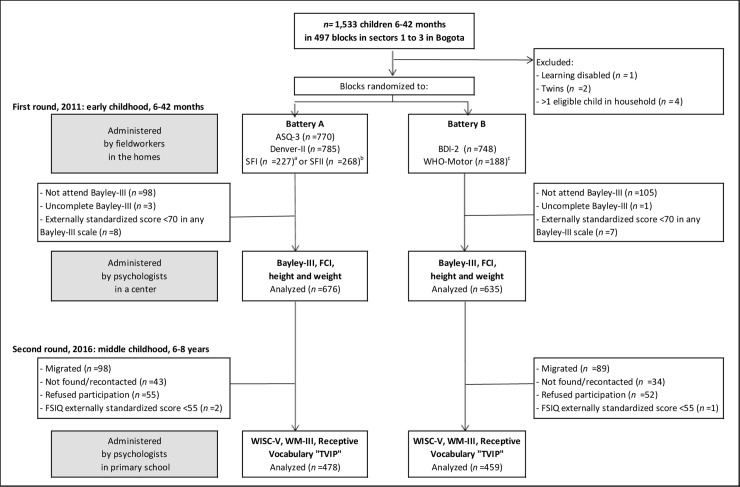
Study design and flow diagram of study participants.ASQ-3 (Ages and Stages Questionnaires, third edition); Denver-II (Denver Developmental Screening Test, second edition); SFI (MacArthur-Bates Communicative Development Inventories, Short-Form I in Spanish); SFII (MacArthur-Bates Communicative Development Inventories, Short-Form II in Spanish); BDI-2 (Battelle Developmental Inventory screener, second edition); WHO-Motor (World Health Organization Gross Motor Milestones); Bayley-III (Bayley Scales of Infant and Toddler Development, third edition); FCI (Family Care Indicators); WISC-V (Wechsler Intelligence Scale for Children, fifth edition); WM-III (Woodcock-Muñoz Test of Achievement, third edition); “TVIP” (Peabody Picture Vocabulary Test-Revised, Spanish version, adapted/selected subset of words). a Children 8–18 months. b Children 19–30 months. c Children 6–15 months.